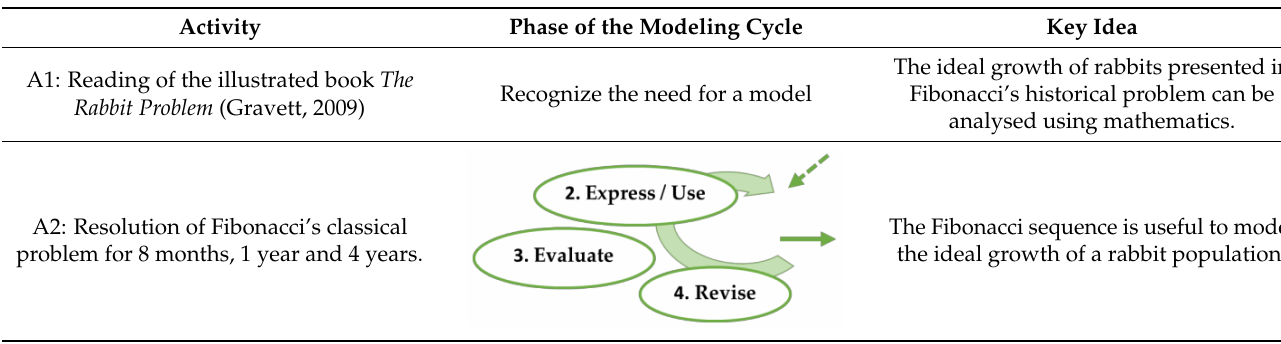
Table 1. Summary of the phases, activities and key ideas developed throughout the sequence. In activities A2 to A5 the initial model of the students was engaged (expression/use), put to test (evaluated) and reformulated to include new aspects